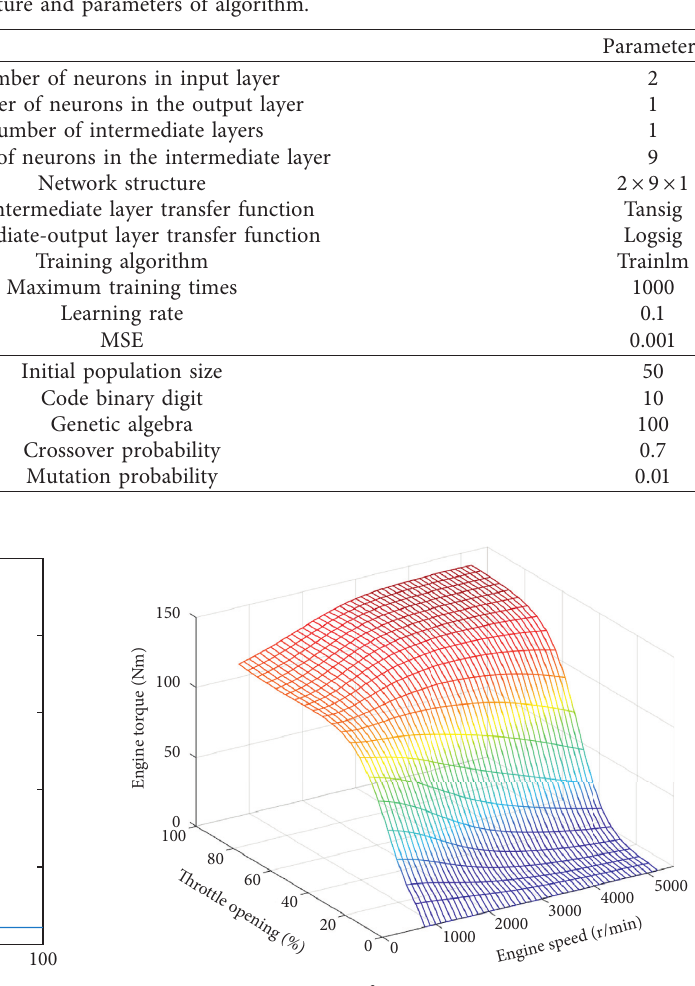
Figure 6: MAP of engine torque estimation.